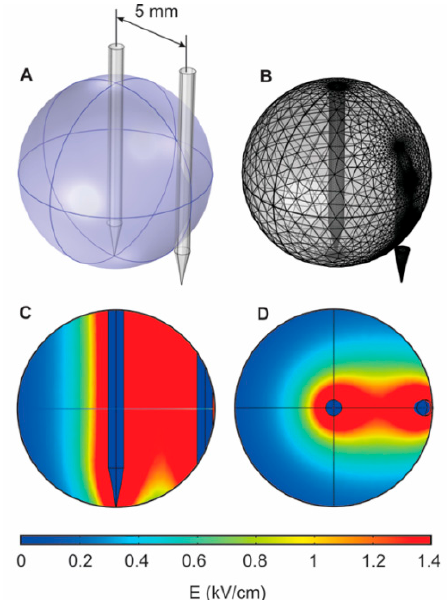
Figure 3. The results of the FEM simulation (1.4 kV/cm pulse), where A ) the positioning of the needle electrodes; B ) mesh structure; C , D ) spatial distribution of electric field.